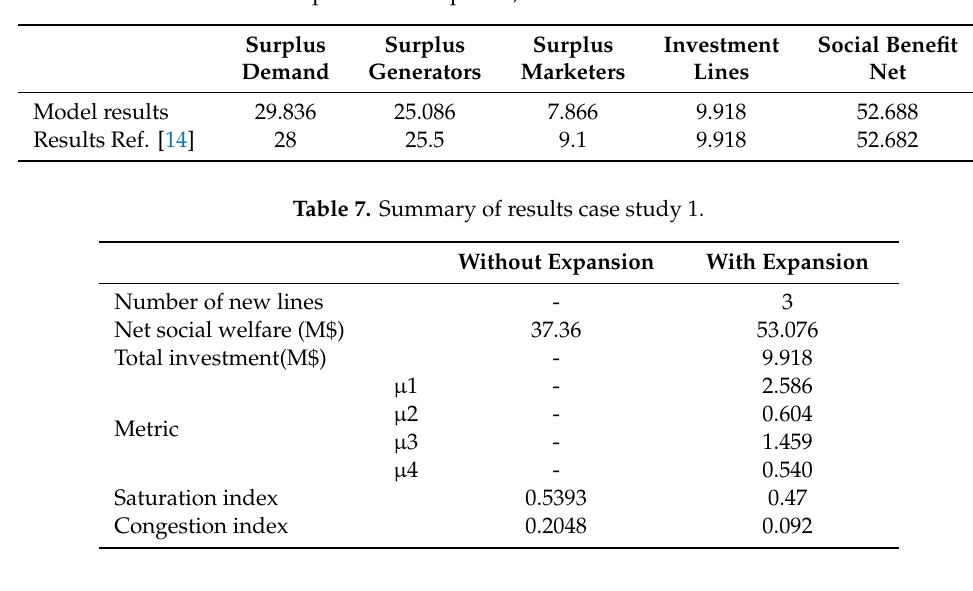
Table 6. Comparison of surpluses, investment and social benefit.